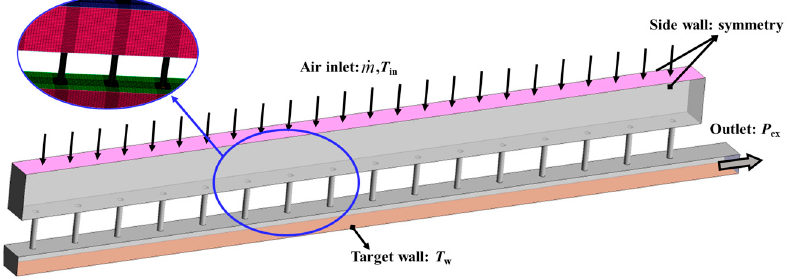
Figure 6. Computation domain with a close-up of the grid.